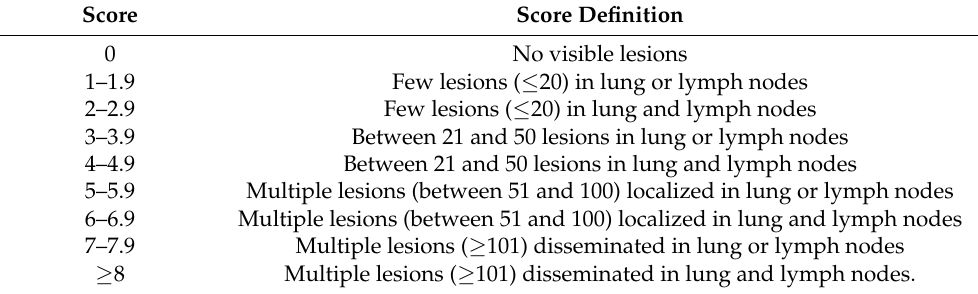
Table 2. Definition of lesion scores in the carcass inspections at slaughter of goats vaccinated against tuberculosis (TB) with different BCG vaccine protocols and challenged with a wild-type strain of Mycobacterium bovis